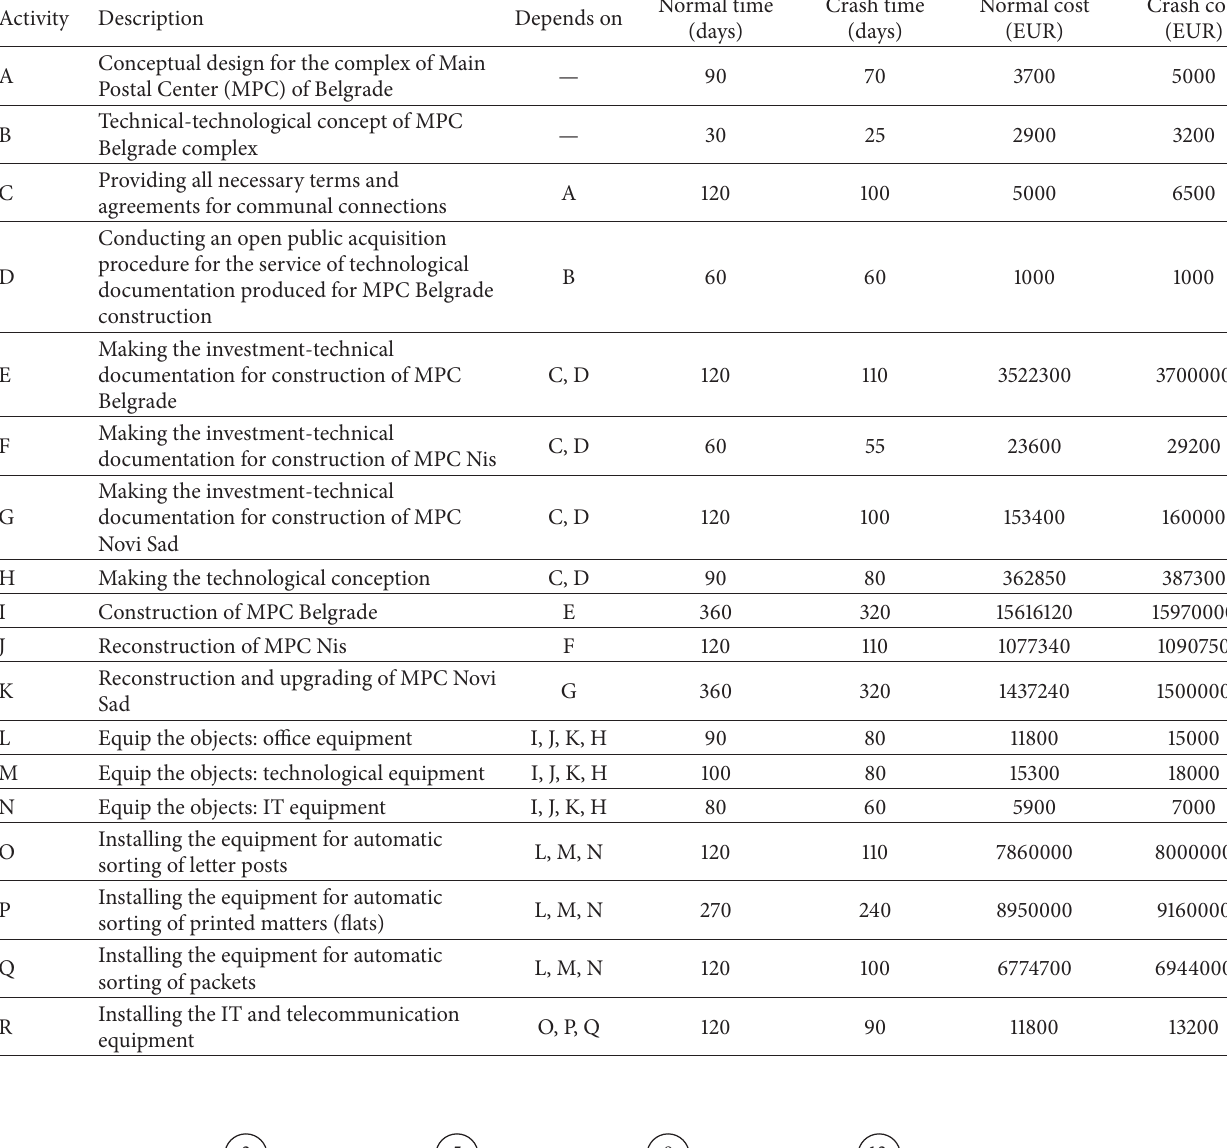
Table 1: Activities, time, costs, and relationships for the considered project network.